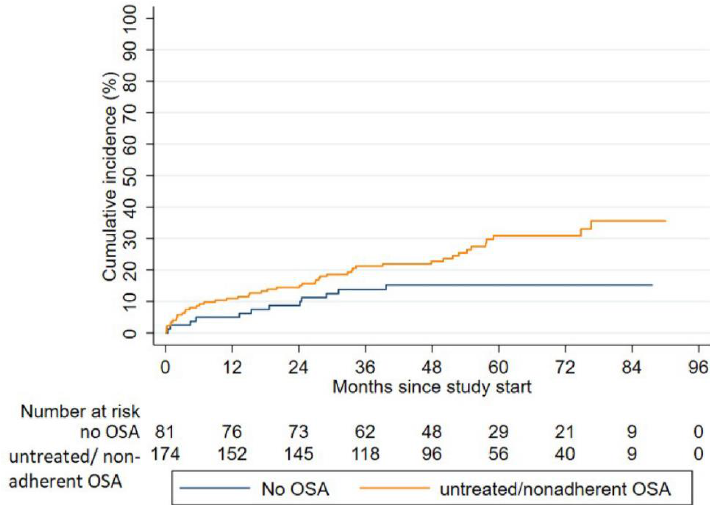
Figure 3. Cumulative incidences of the composite endpoint in the observational arm. OSA, obstructive sleep apnea.